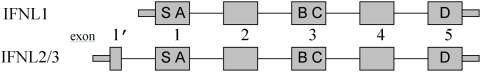
Gene structure of human IFNL1, IFNL2 and IFNL3.Each numbered box represents an exon (not drawn to scale). The shorter extensions at the terminal exons represent noncoding DNA. The letters inside the boxes are protein structural features: (S)ecretion peptide, helix (A), helix (B), helix (C) and helix (D).